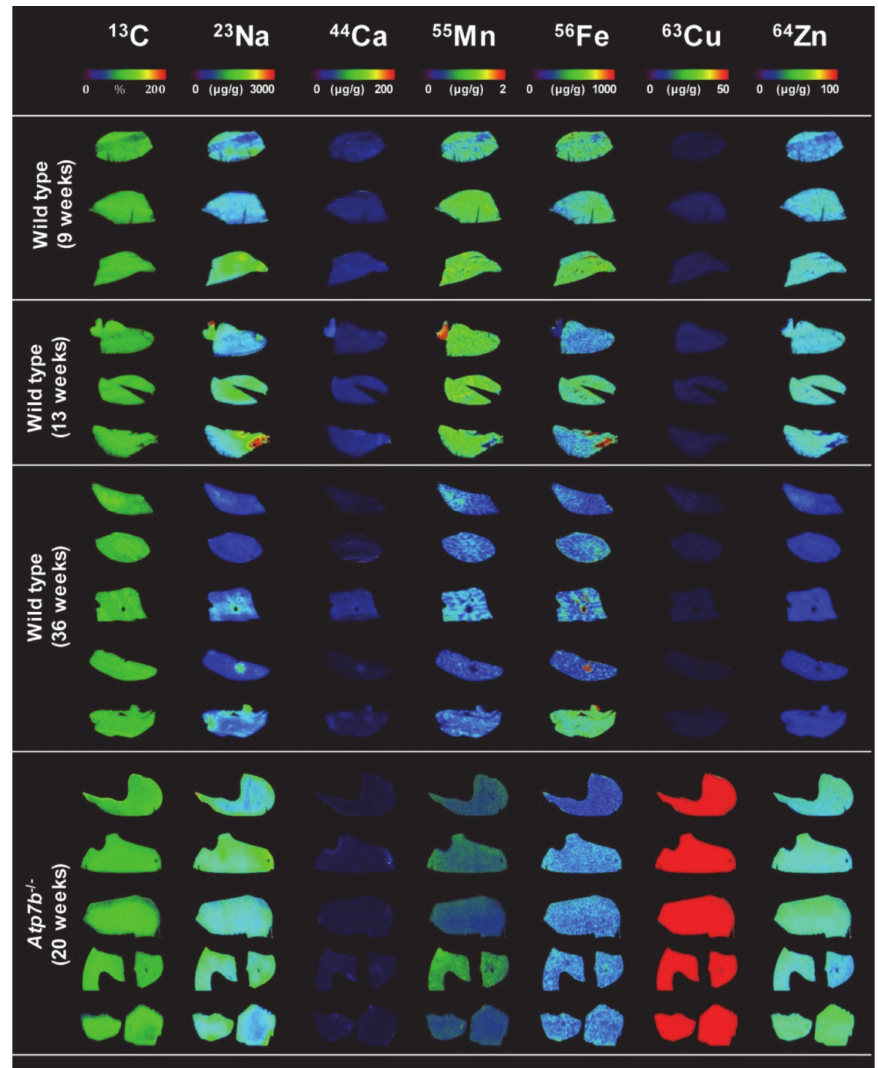
Figure 5. Analysis of the Atp7b – / – copper overload model by LA-ICP-MS. Shown are representative LA-ICP-MS images of carbon ( 13 C), sodium ( 23 Na), calcium ( 44 Ca), manganese ( 55 Mn), iron ( 56 Fe), copper ( 63 Cu), and zinc ( 64 Zn) in sections from livers of wild type and Atp7b – / – mice with indicated age. In the Atp7b – / – mice, copper overload is vividly detected by LA-ICP-MS. In this analysis, 13 C was used for